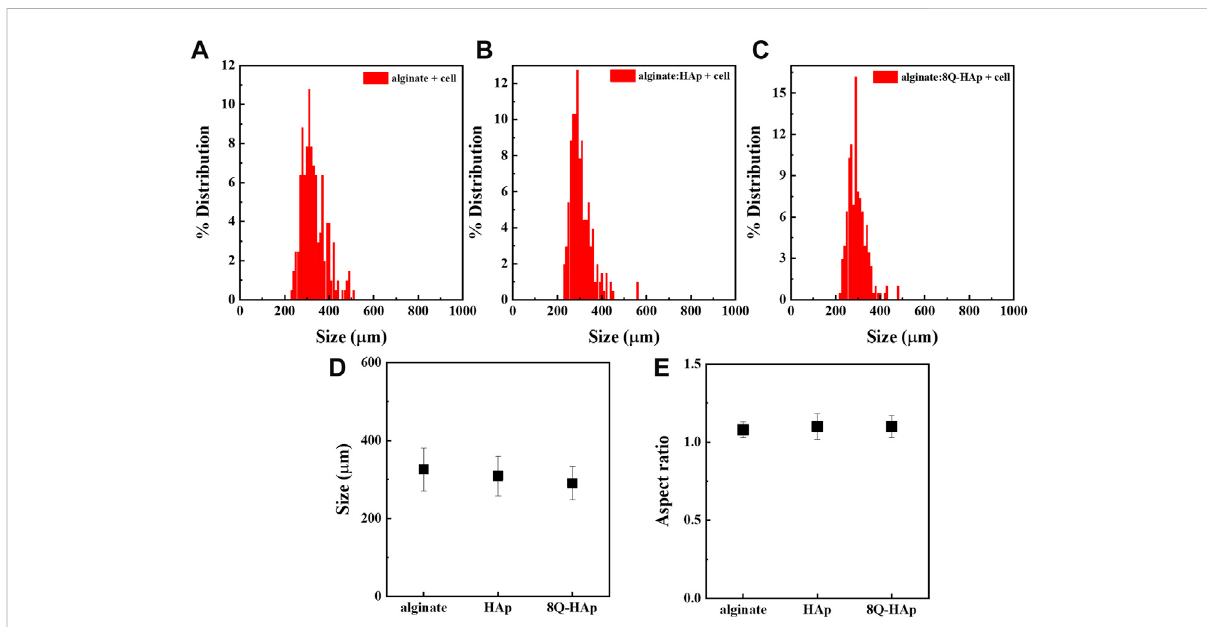
FIGURE 3 Size distribution of different concentrations of cell-encapsulated quercetin-preloaded HAp hybrid microspheres. (A) Alginate with cells (without HAp nor quercetin) (B) alginate:HAp (C) alginate: 8 wt% quercetin-preloaded HAp (D) size analysis for each group; and (E) aspect ratio for each